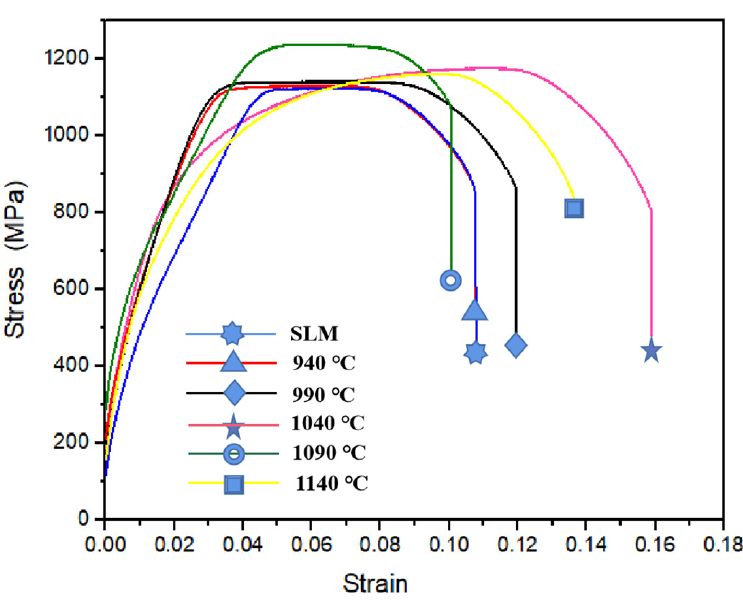
Figure 8. Stress–strain curves of SLM-formed specimens and heat-treated specimens. Figure 9 shows the SEM morphology results for the tensile fracture of the 17-4PH high-strength steel samples formed using the SLM-based method and processed at different solution temperatures in the 940–1140 ◦ C range. After heat treatment, the tensile strength reached 1200 MPa. The elongation was in the range of 0.10 to 0.16. The tensile fracture surface consists of three distinct regions: the fiber, radiation, and shear lip regions. Figure 9a shows that many dimples and some micropores (orange arrows) formed on the surface of the untreated SLM-formed sample, and the sample exhibited a ductile fracture. As shown in Figure 9b, the sample that was treated at the solution temperature of 940 ◦ C exhibited an obvious cleavage surface (marked by the orange circle) and shallow holes. Dimples were large and uneven, indicating a mixture of ductile and brittle fractures. With an increase in the solution temperature (as shown in Figure 9c for the solution temperature of 990 ◦ C), the torn edge of the tensile part decreased and shortened, and the dimples became finer. As shown in Figure 9d, when the solution temperature increased to 1040 ◦ C, the dimples on the fracture surface of the sample became similar in size and evenly distributed, which was also the reason for the high degree of elongation. The fracture surface of the sample exhibited an obvious necking phenomenon, which is a typical ductile fracture mechanism. As shown in Figure 9e, for the solution temperature of 1090 ◦ C, the tensile strength of the sample increased, but the elongation decreased, resulting in a large number of cleavage surfaces and holes in the sample. As shown in Figure 9f, for the solution temperature of 1140 ◦ C, the austenite in the sample structure reduced the strength of the material but improved the plasticity, tensile rate, cleavage surface, and micropore content of the material. After the heat treatment, the precipitated phase caused the formation of micropores during tension. The speed of the microporous polymerization process affects the toughness of the